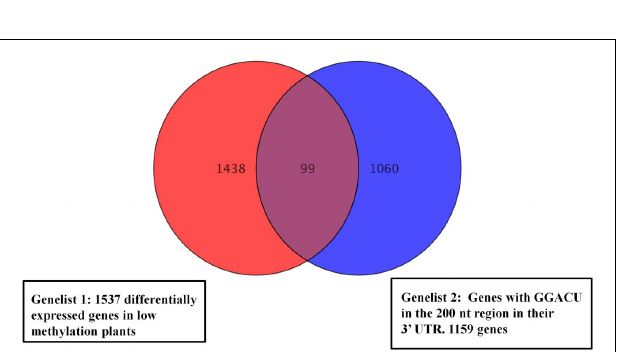
FIGURE 6 |Venn diagrams representing overlapping genes between the list of cDNAs with GGACU in the last 200 nt of the 3 (cid:2) UTR and the differentially expressed genes in the low methylation plants. Ninety-nine Genes from the low methylation plants had at least one GGACU in the last 200 nt end of their 3 (cid:2) UTR. Genes with no annotated 3 (cid:2) UTR were not